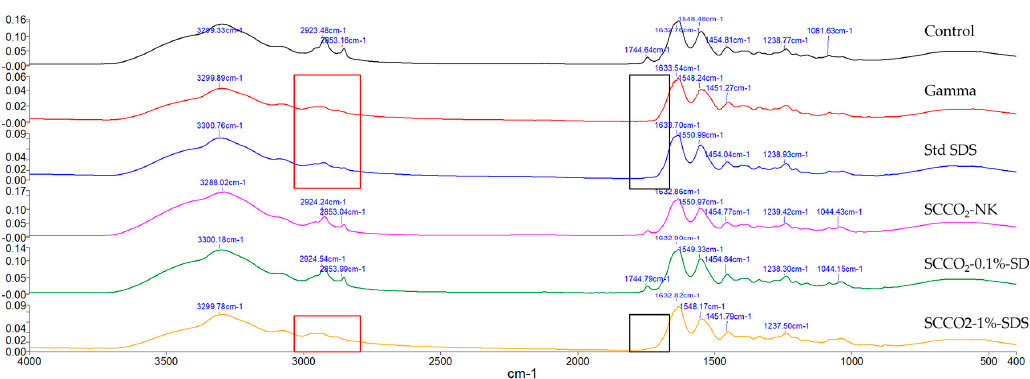
Figure 4. Representative FTIR spectra of the control, gamma-irradiated, standard-SDS-treated, SCCO 2 -NK-treated, SCCO 2 -0.1%-SDS-treated, and SCCO 2 -1%-SDS-treated tendons. The red and black boxes highlight the reductions of absorption peaks associated with CH 2 and carbonyl groups, respectively.